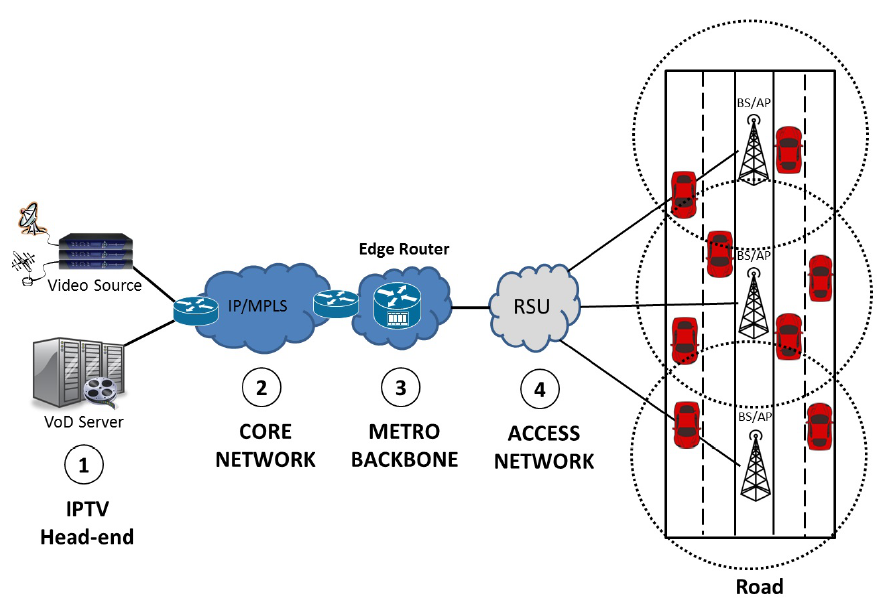
Figure 2. Main components of a VANET-based IPTV